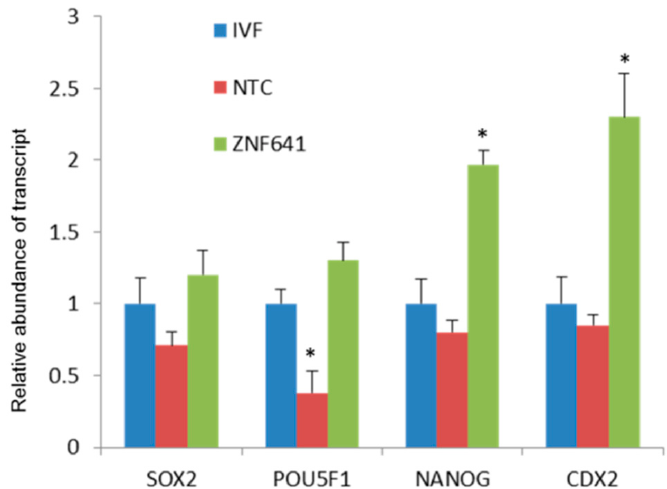
Figure 5. Effects of ZNF641 overexpression on the pluripotent genes in cloned blastocysts. The abundance of a gene transcript was set as “1” in the IVF blastocysts and the relative expressions were calculated in the cloned embryos. In the same cluster, an asterisk superscript indicates the difference relative to the IVF counterpart ( p < 0.05).